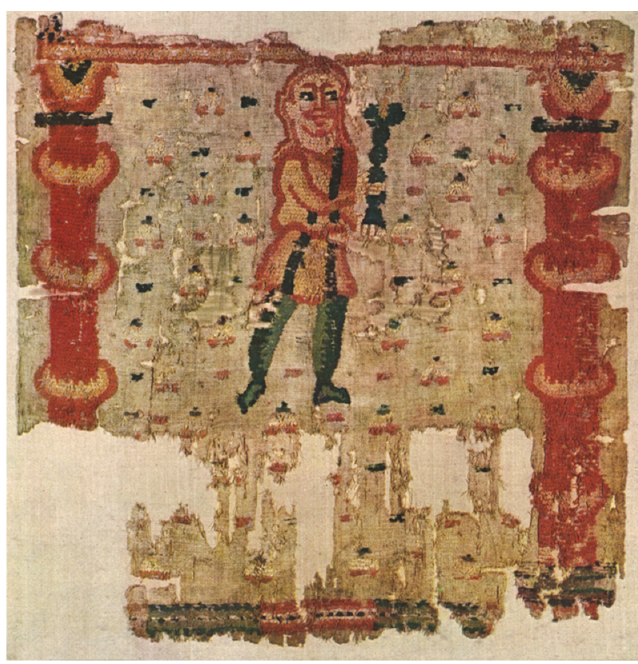
Figure 12. Curtain , 5th–6th century CE. Byzantine; Egypt. Weft-loop pile in wool on plain-weave linen ground; 85 × 88 cm (33 1/2 × 34 5/8 in.). Staatliche Museen zu Berlin, Skulpturensammlung und Museum für Byzantinische Kunst (formerly in the Kaiser-Friedrich-Museum, lost in World War II), 9223 (after Wulff and Volbach 1926, p. 2). © Staatliche Museen zu Berlin, Skulpturensammlung